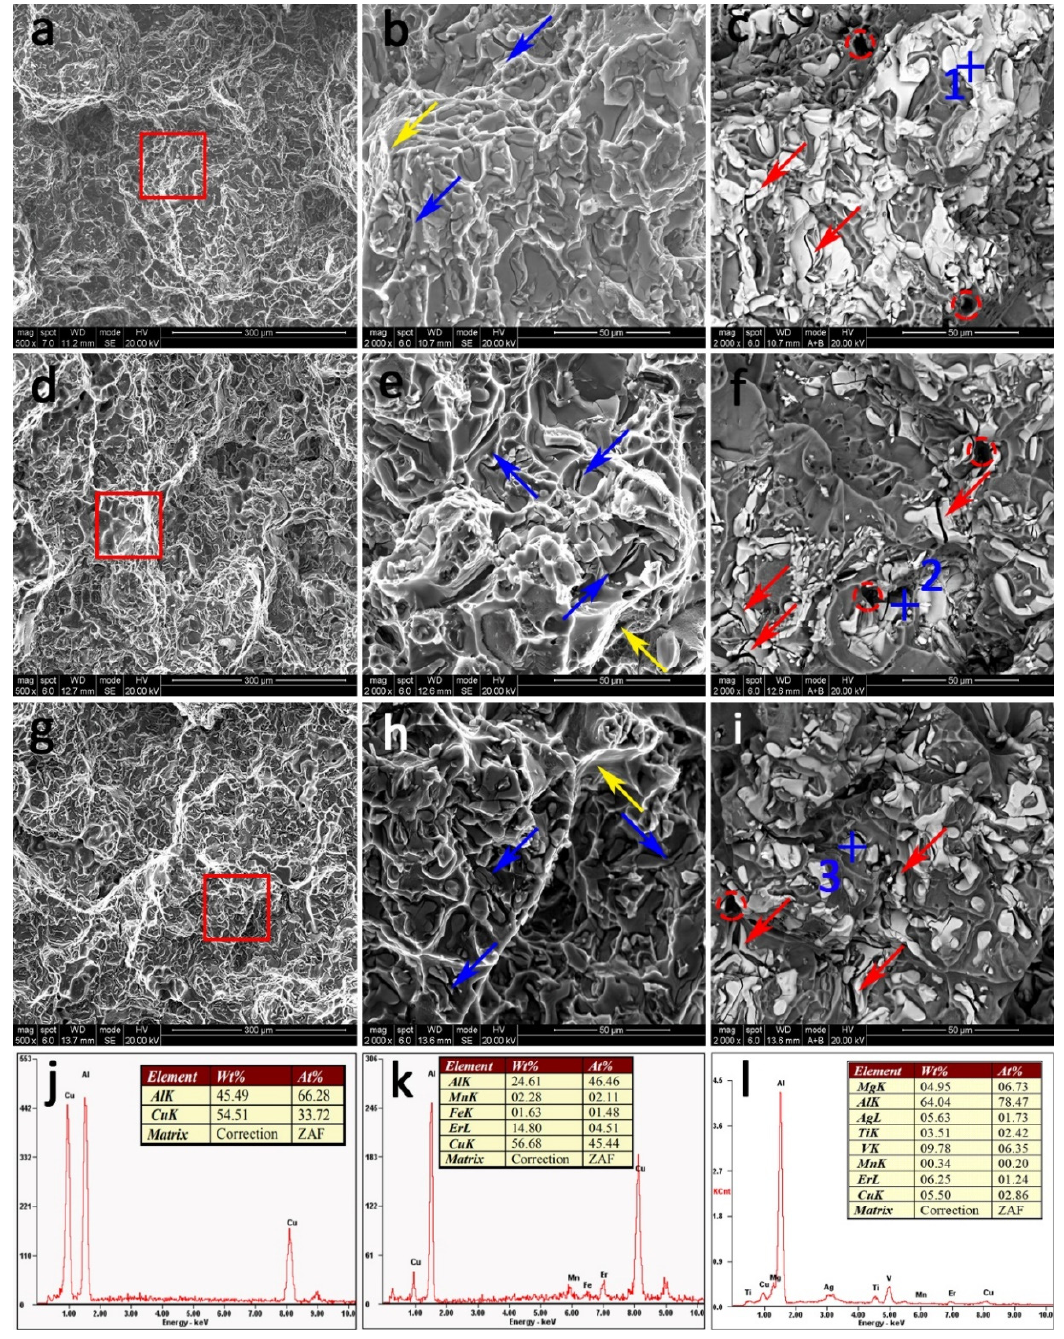
Figure 12. SEM images of the fracture surfaces of peak-aged alloys at room temperature in different magnifications. ( a – c ) Er-free; ( d – f ) 0.09Er; ( g – i ) 0.20Er; ( j – l ) EDS spectrum of points 1, 2 and 3.